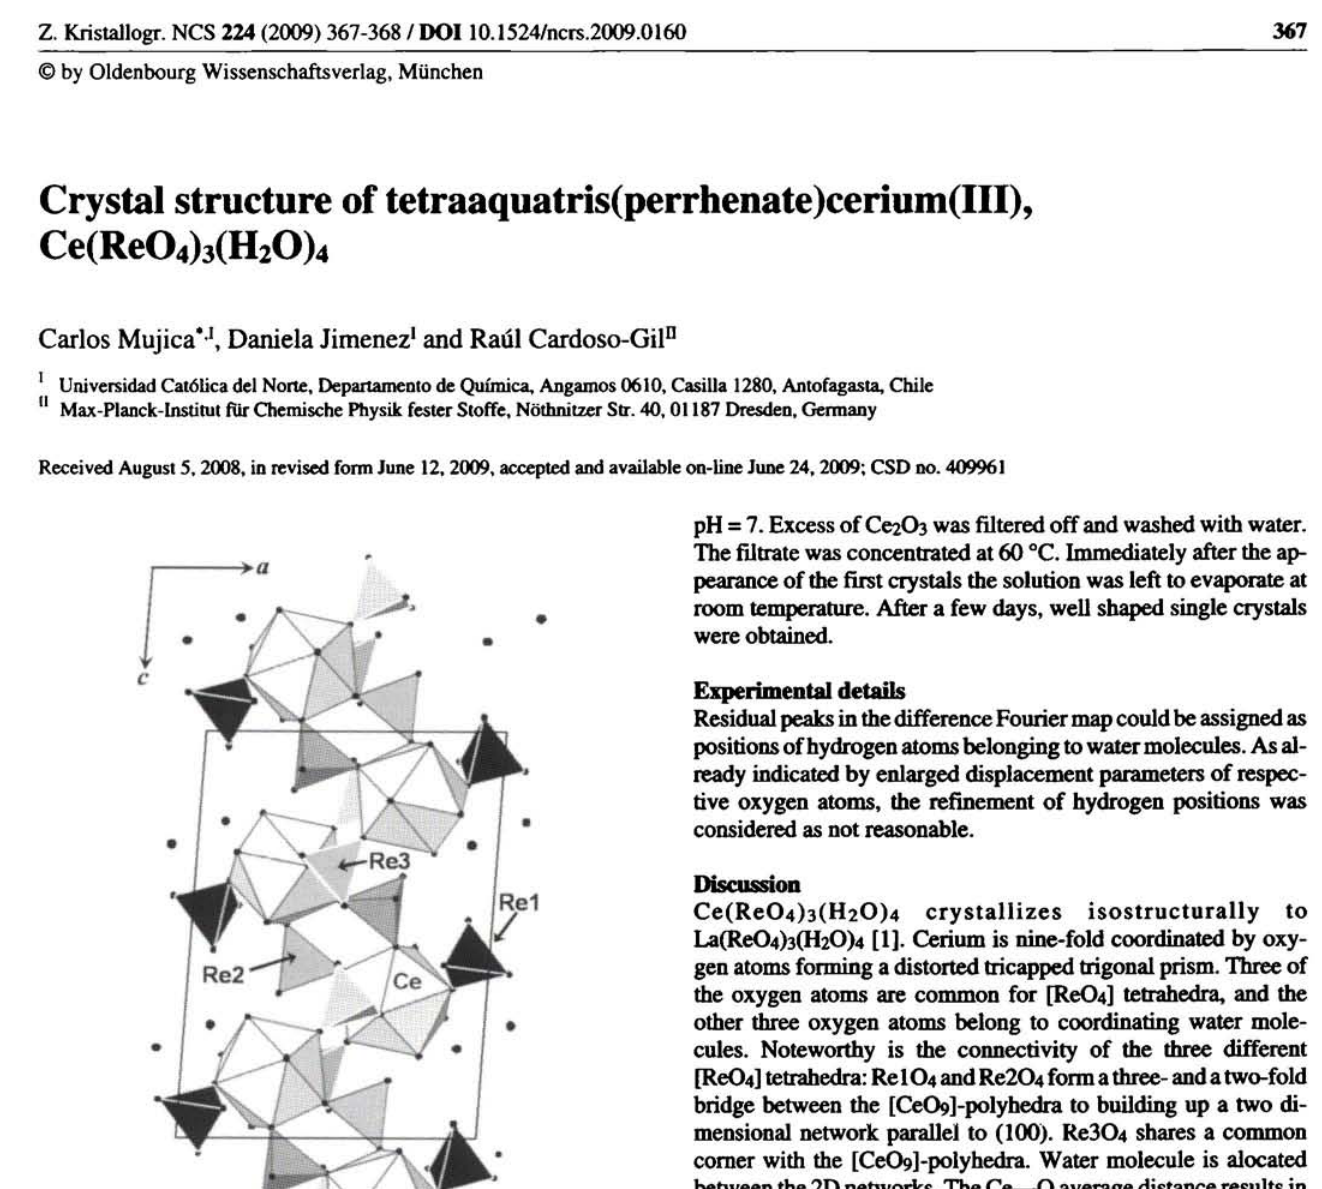
Table 1. Data collection and handling. Crystal: